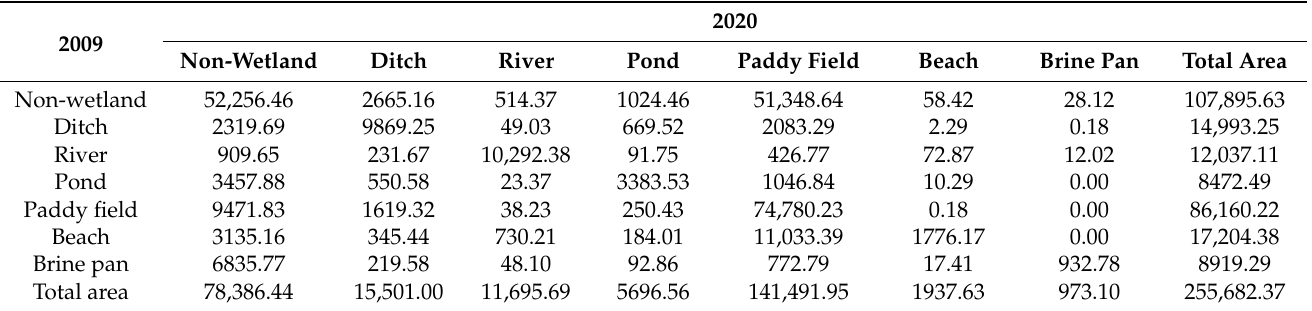
Table 8. Area of the landscape conversion matrix from 2009 to 2020 (hm 2